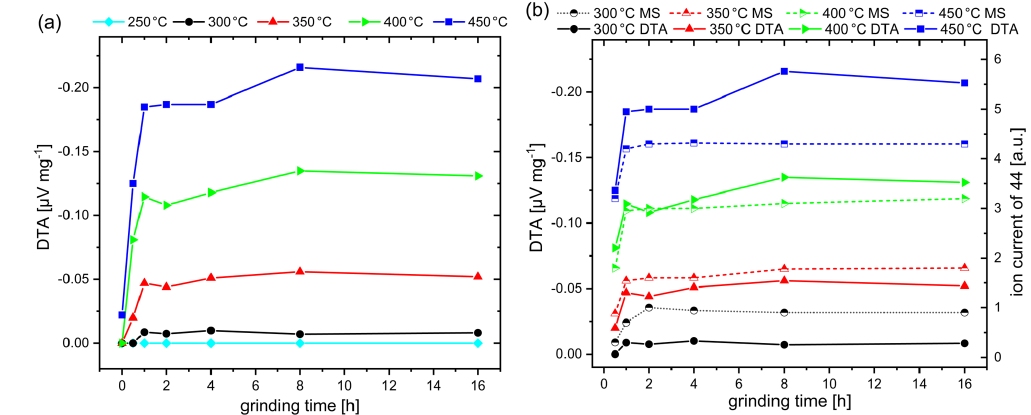
Figure 3. (a) DTA response obtained on CH 4 exposure (1vol% in dry air) of commercial Co 3 O 4 catalysts as a function of grinding time and operating temperature. (b) DTA response in comparison to MS response obtained by simultaneous